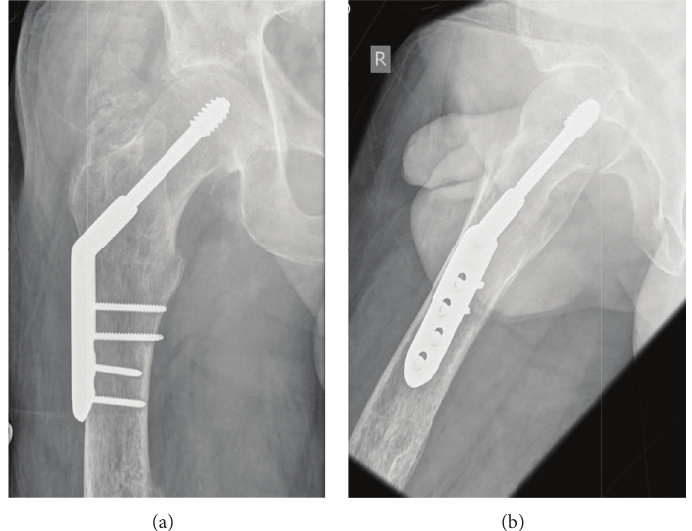
Figure 3: Postoperative radiographs demonstrating satisfactory DHS fixation of the right intertrochanteric hip